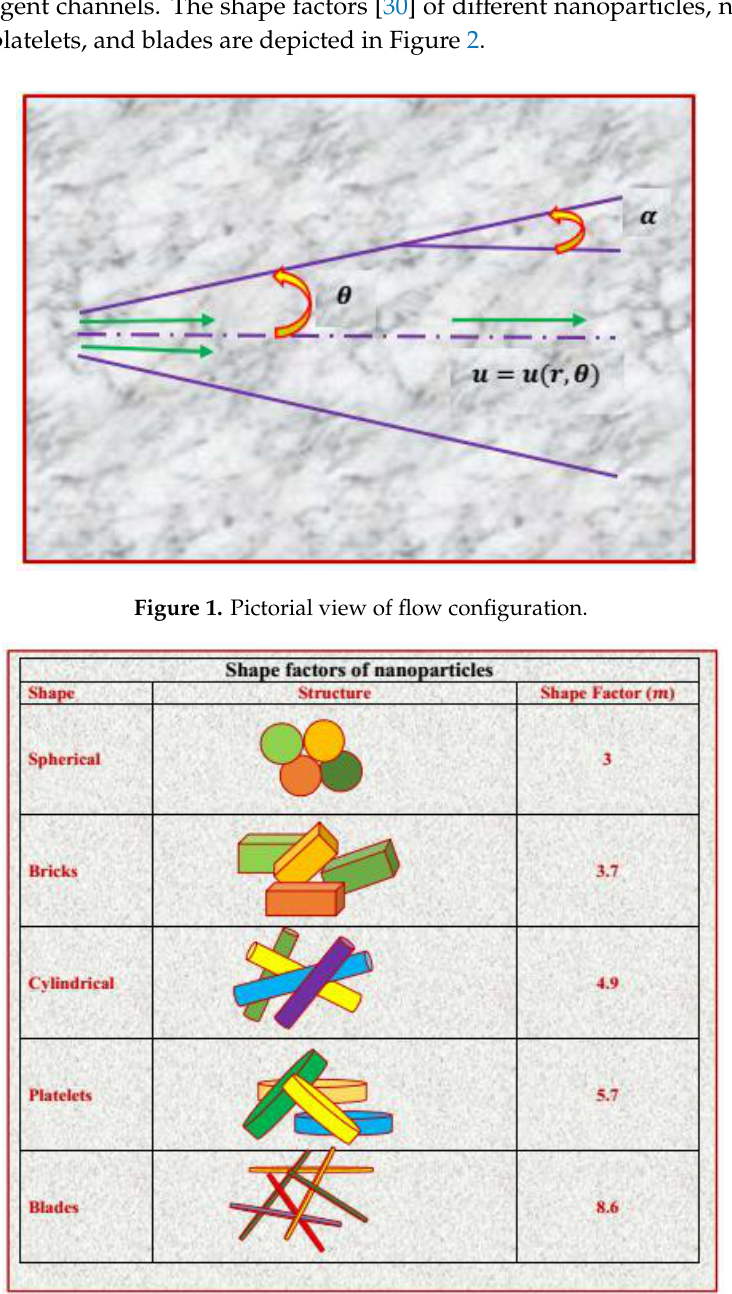
Figure 2. Shape factors of the nanoparticles.